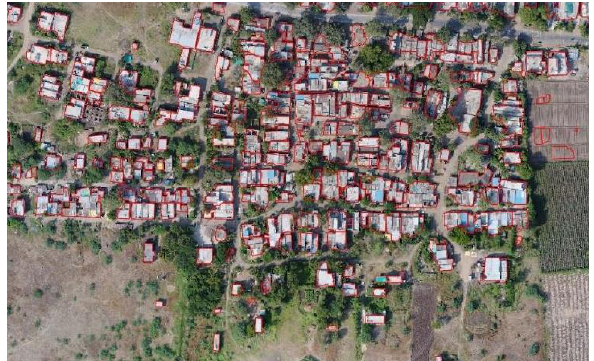
Figure 7 . 1 Ineffective separation of buildings due to large contact area Figure 8 . 2 Dataset from Maharashtra ( Indshine, 2018 ) Unstructured building dataset taken from UAV of village in Maharashtra . Resolution of image is 50cm